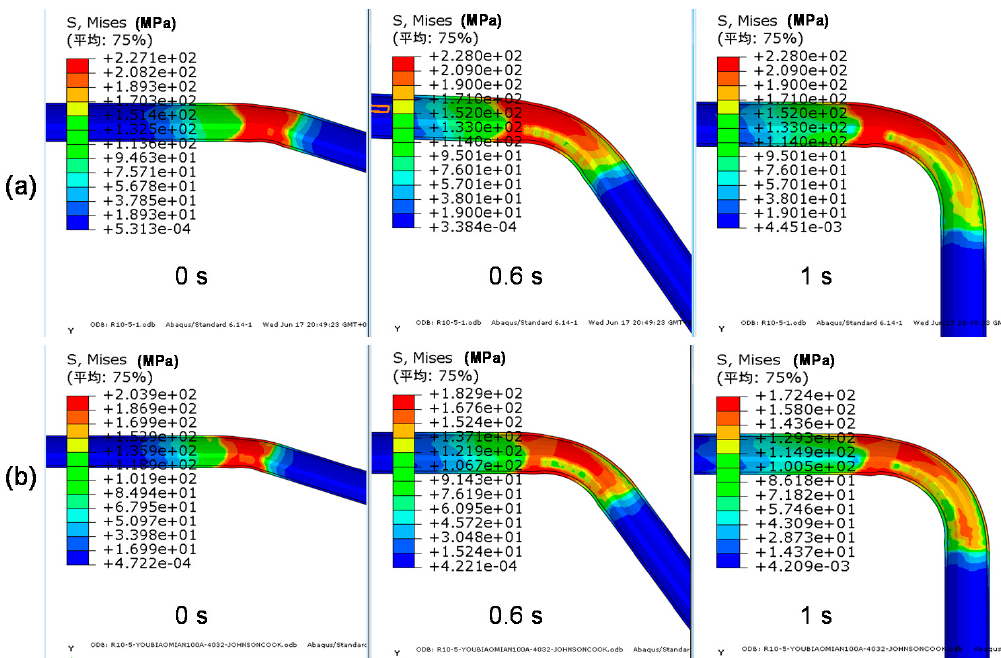
Figure 4. Variation of Mises stress distribution with time in ( a ) non-EA and ( b ) EA RDB process of micro-tube with 5 mm diameter and 10 mm bending radius.